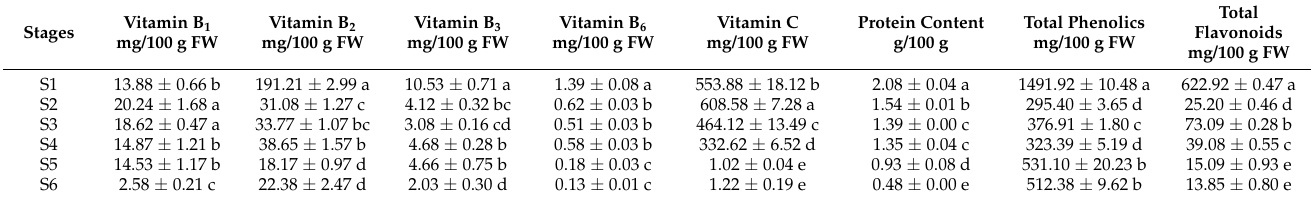
Table 3. Dynamic changes of antioxidant component and protein content during S. obovatifoliola subsp. urophylla fruit